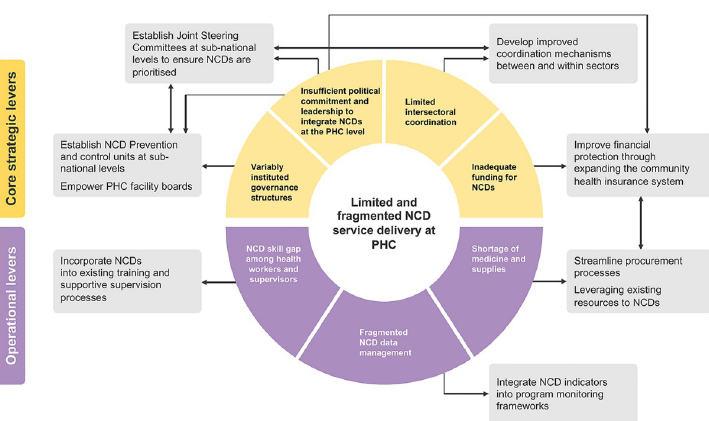
Fig 2. Study findings to provide integrated and people-centred NCD prevention and control through PHC in Ethiopia, 2021.